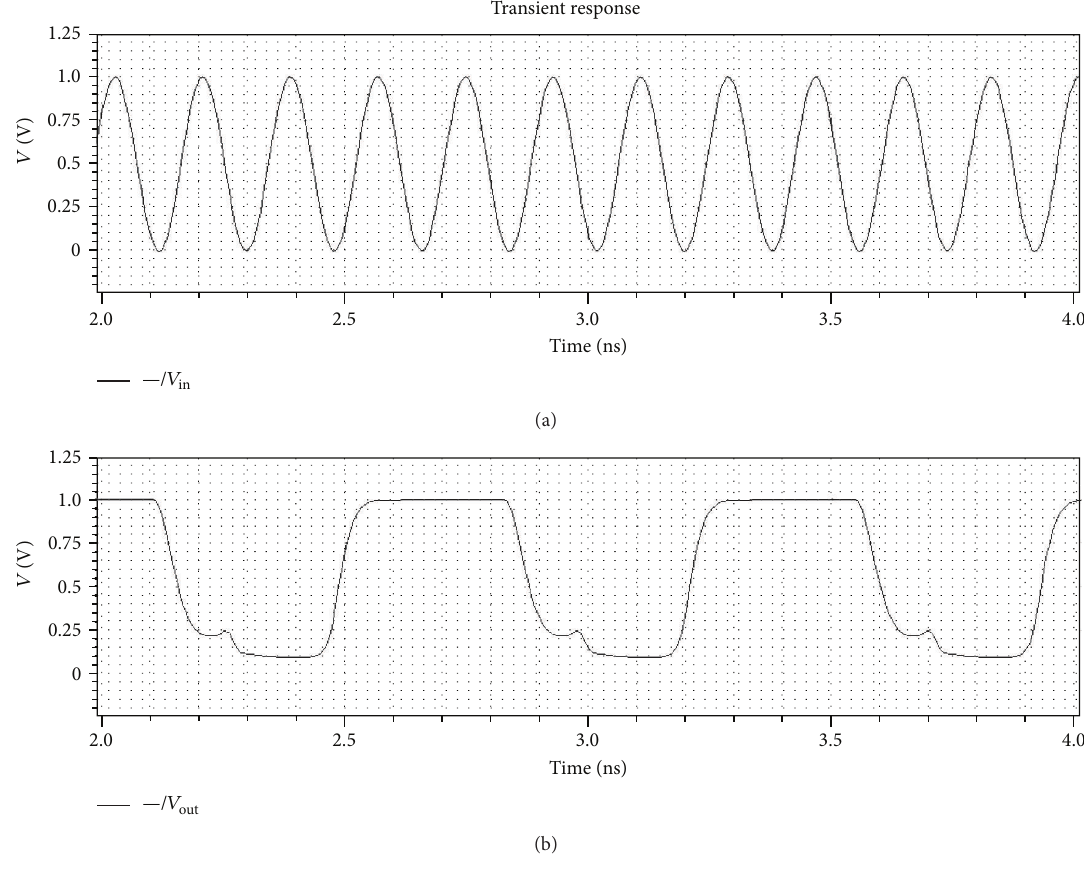
Figure 8: Sine input at 5.55